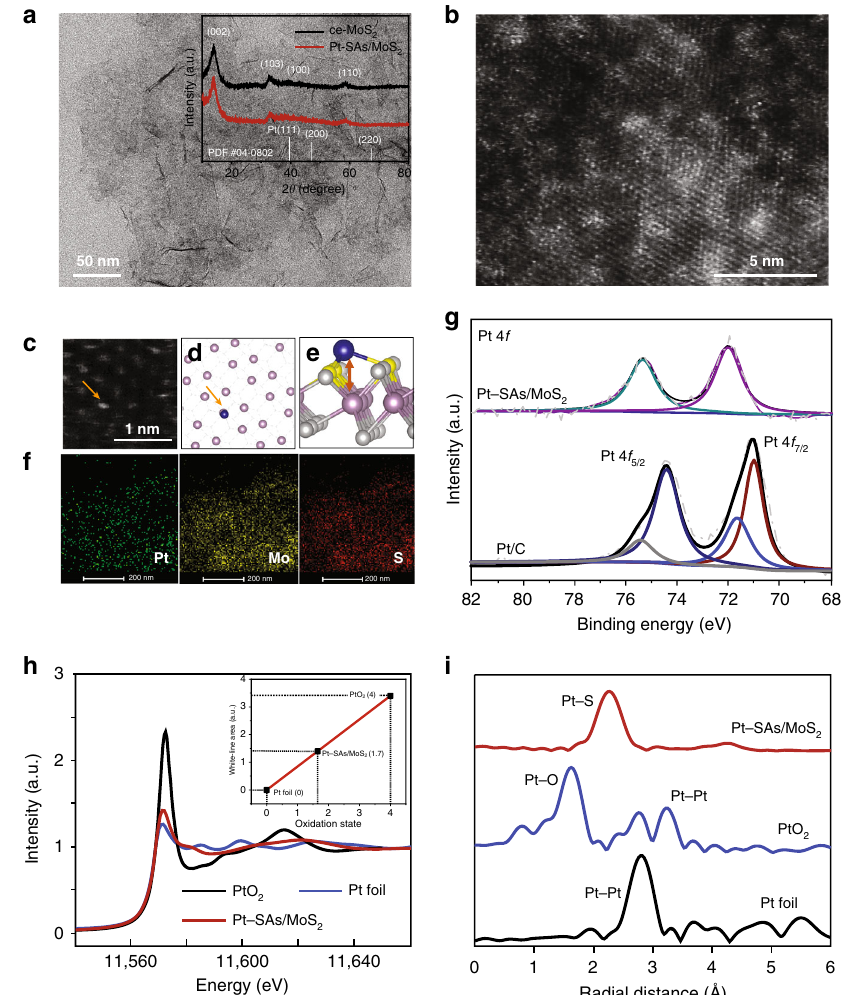
Fig. 2 Structural characterization of Pt-SAs/MoS 2 . a Conventional TEM images of a freshly prepared Pt-SAs/MoS 2 sample. The inset shows the XRD patterns of ce-MoS 2 and Pt-SAs/MoS 2 samples. b HAADF-STEM image of Pt-SAs/MoS 2 (single Pt atoms highlighted by red circles). c Magni fi ed HAADF- STEM image of Pt-SAs/MoS 2 and its corresponding top ( d ) and front ( e ) views of DFT-optimized structural model (purple: Mo; gray: S; yellow: S for the Pt attachment; blue: Pt), showing a typical environment of a Pt atom at sites beyond the Mo top site. The focal position of gray dash line in Fig. 2d represents the S atom. f Mapping images of Pt, Mo, and S atoms. g Pt 4f XPS spectra of Pt-SAs/MoS 2 and commercial Pt/C. h The normalized XANES spectra of Pt foil, PtO 2 , and Pt-SAs/MoS 2 at the Pt L 3 -edge. The inset shows the average oxidation state of Pt in Pt-SAs/MoS 2 . i Corresponding EXAFS pro fi les from Fig.